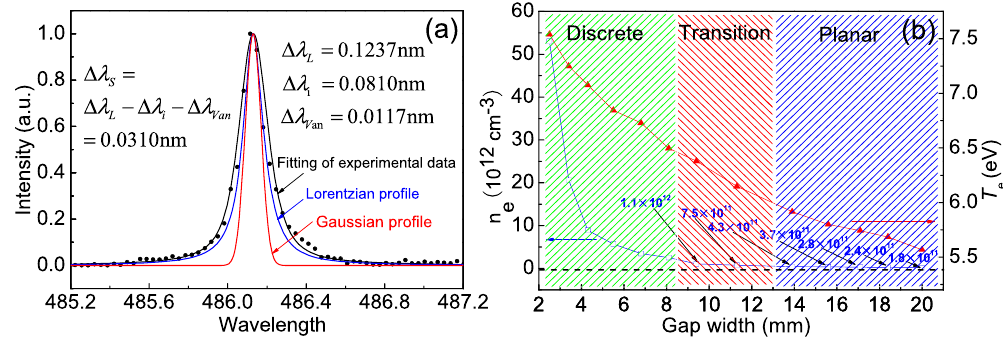
Figure 6. ( a ) Deconvolution process of H β line (486.1 nm) emitted from the discrete discharges with a gap width of 2.5 mm. ( b ) Estimated electron density and electron temperature as functions of the gap width.